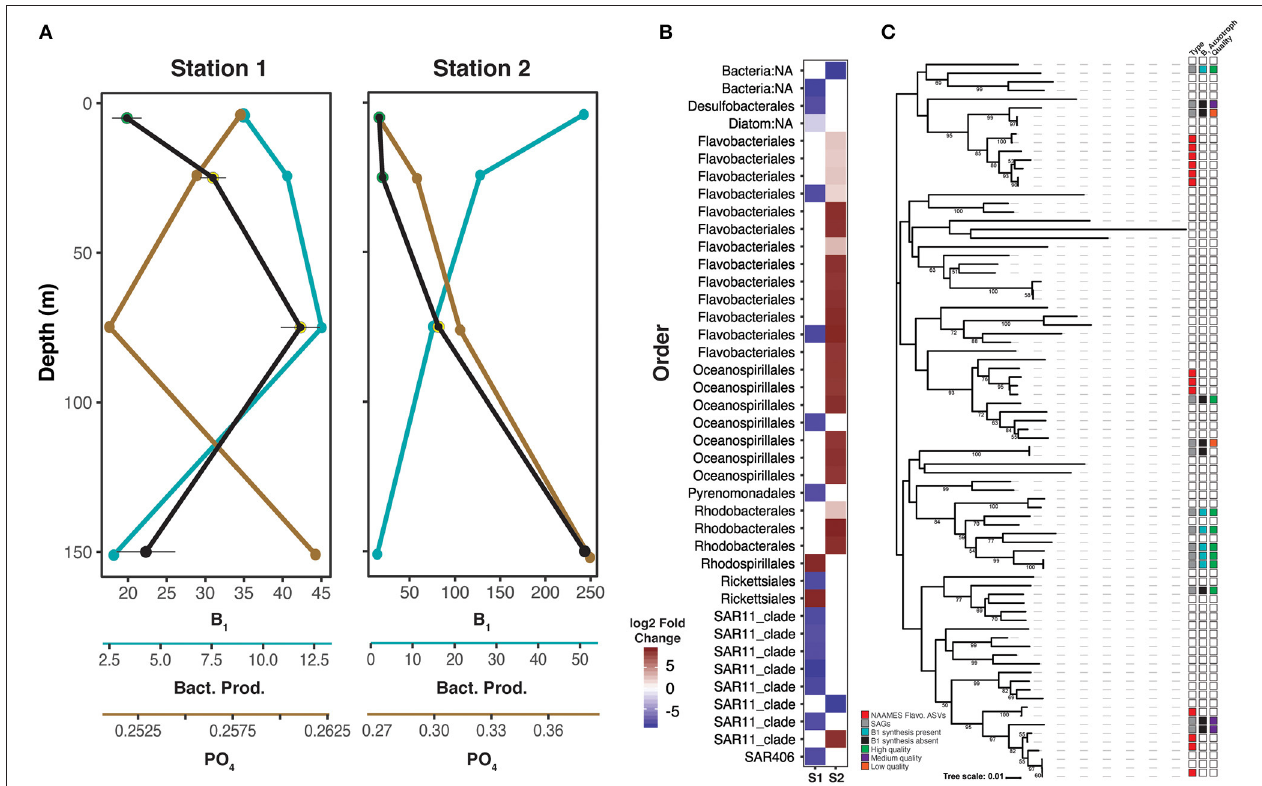
FIGURE 5 | Contrasting oceanographic and microbial dynamics at stations 1 and 2. (A) Depth profiles of dissolved B1 (pM, Black), bacterial production (pmole Leu/L/hr, teal), and phosphate ( µ M, brown) at stations 1 and 2. (B) Heat map of differentially abundant ASVs at depths with high B1 concentration (yellow halos A ) vs. low B1 concentration (green halos A ). Red represents positive log2 fold changes, indicating high ASV abundance at depths with low B1 relative to high B1. Blue represents negative log2 fold changes, indicating high ASV abundance at depths with high B1 relative to low B1. ASVs with a differential abundance (log2 fold change larger than 2 and smaller than − 2) between high and low concentration B1 samples at stations 1 and 2 are plotted. Only samples above 75 meters were considered for this analysis. Taxonomic assignment of the plotted ASVs are shown in the y axis. Full taxonomic information can be found in Supplementary Table 1 . (C) Phylogenetic relationships of 16S rRNA gene sequences from NAAMES4 Flavobacteria ASVs abundant at 5–25m at station 2 (red squares, type column), publicly available Flavobacteria single cell amplified genomes (SAGs; gray squares, type column), and Bacteroidetes ASVs (white squares, type column) retrieved from coastal North Sea (Alonso et al., 2007), and coastal North Carolina bacterioplankton (D’ambrosio et al., 2014). Publicly available Flavobacteria SAGs ( Supplementary Tables 2 – 4 ) were queried for evidence of B1 synthesis capacity. Genomes where B1 synthesis capacity was found are labeled with teal squares in the B1 auxotroph column, while black squares indicate putative B1 auxotrophy ( Supplementary Table 4 ). SAG genome quality is indicated in the quality column, with high quality ( > 90% completeness, < 5% contamination) in green, medium quality ( > 65% completeness, < 10% contamination) in purple, and low quality ( < 65% completeness, contamination < 10%) in orange ( Supplementary Table 3 ). All node labels, methods used for analysis, and detailed results are provided in Supplementary Figure 2 , Supplementary Tables 2 – 4